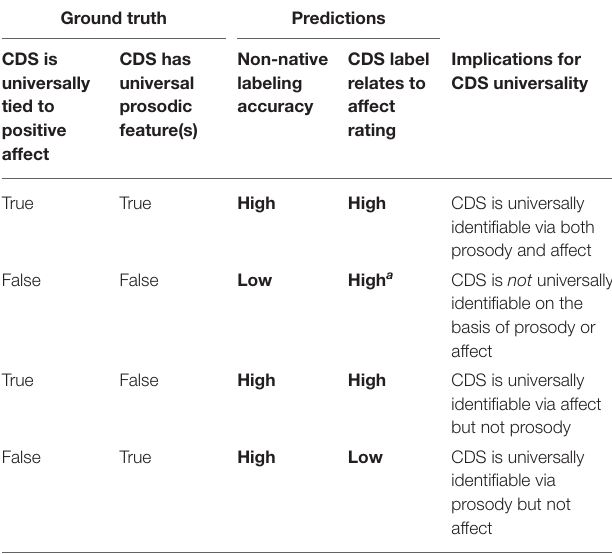
TABLE 1 | Overview of predicted outcomes for the present analysis, given various (simplified) ground truth conditions. Ground